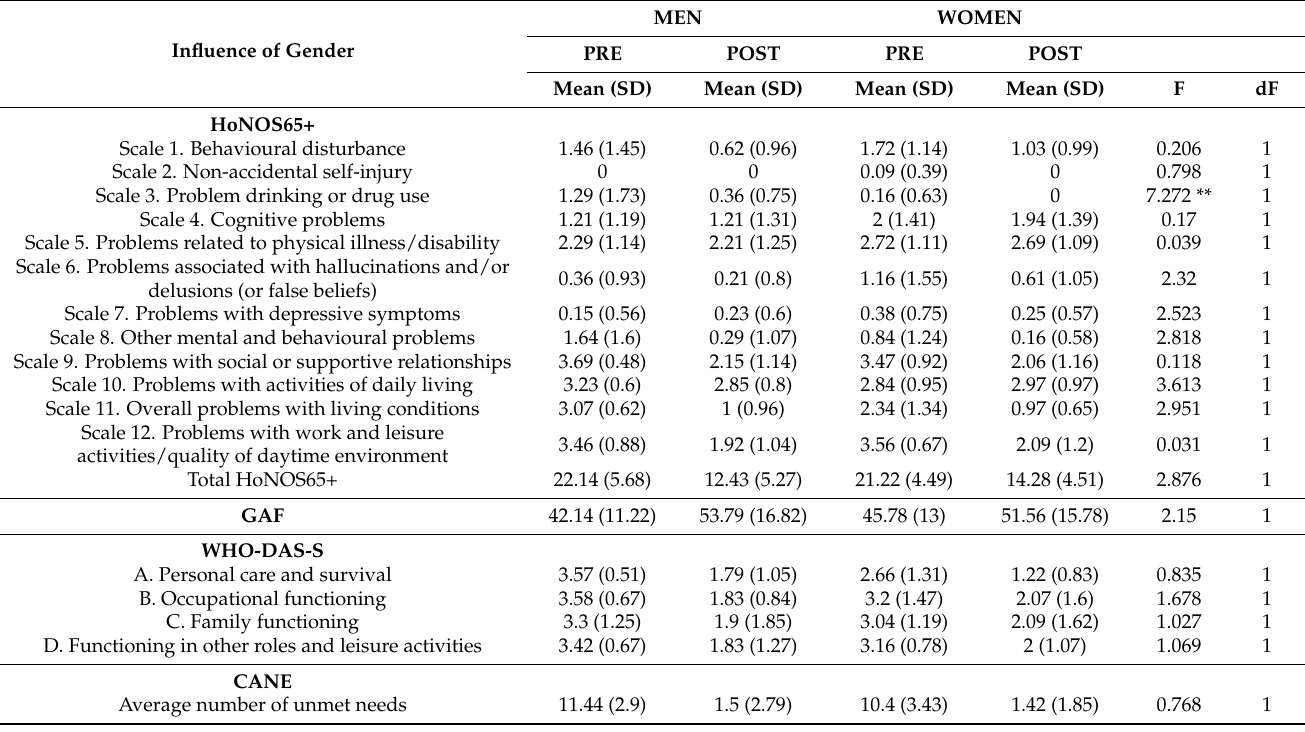
Table 8. Influence of gender on intervention